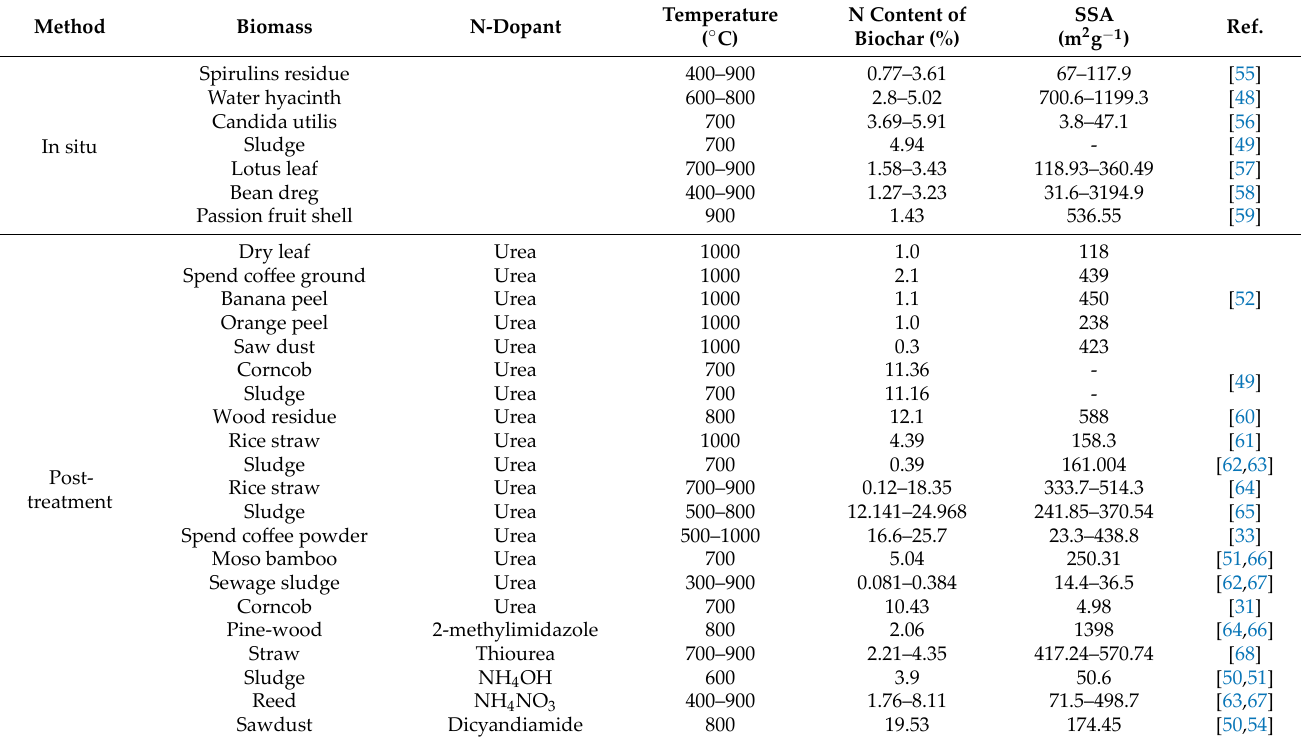
Table 1. Preparation of N‑doped biochar from different biomass by